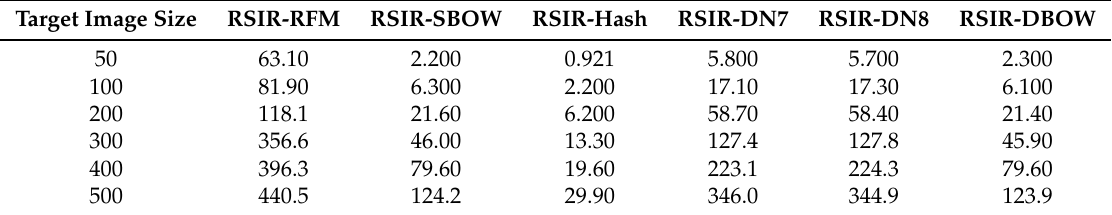
Table 7. Computational cost of similarity matching based on different RSIR methods. (Unit: Millisecond) Target Image